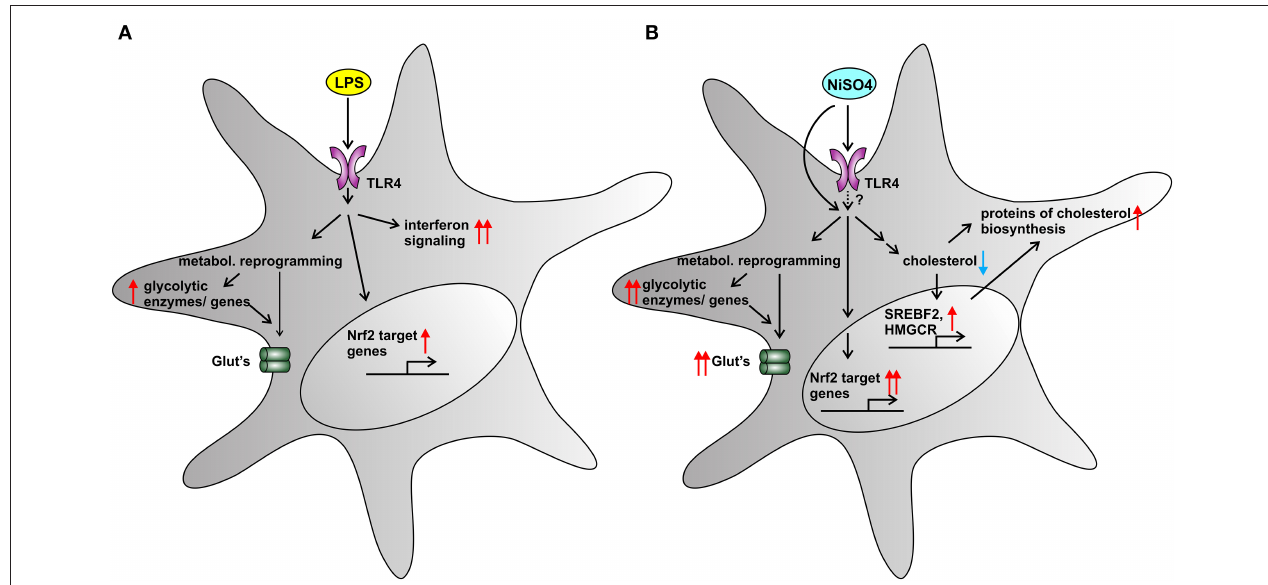
FIGURE 5 | Summarizing Figure. Cellular effects of two TLR4-activators on MoDCs: LPS (A) and NiSO 4 (B) . (A) LPS-treatment induced a metabolic shift toward glycolysis and a weak Nrf2-dependent stress response. IPA pathway analysis revealed a strong upregulation of interferon signaling. (B) NiSO 4 -treated cells showed a distinct upregulation of glycolytic enzymes both on mRNA and protein level, suggesting metabolic reprogramming and hypoxia-like conditions. The metal allergen NiSO 4 also triggered a pronounced Nrf2-dependent stress response that culminated in upregulation of Nrf2-target genes. Most strikingly, NiSO 4 induced a cellular cholesterol depletion in MoDCs, which was reflected in the upregulation of genes and proteins involved into cholesterol biosynthesis. We speculate that haptenation to other cellular proteins than TLR4 also contributed to the observed changes. A blue arrow indicates downregulation and red arrows indicate upregulation. A pronounced change is indicated by two